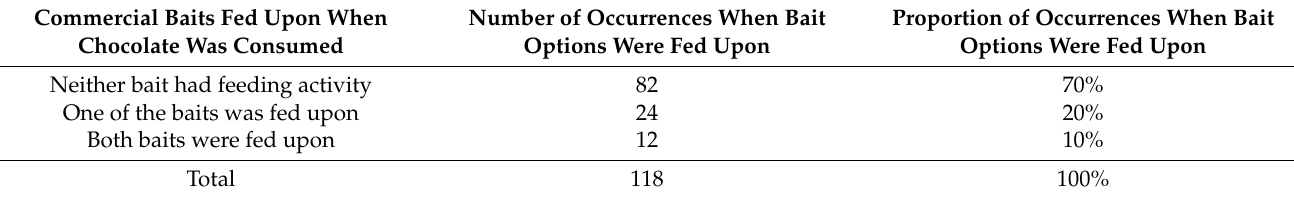
Table 2. Comparison of feeding activity on chocolate spread and two commercial non-toxic baits during the 12 month study. Commercial Baits Fed Upon When Number of Occurrences When Bait Proportion of Occurrences When Bait Chocolate Was Consumed Options Were Fed Upon Options Were Fed Upon Neither bait had feeding activity 82 70% One of the baits was fed upon 24 20% Both baits were fed